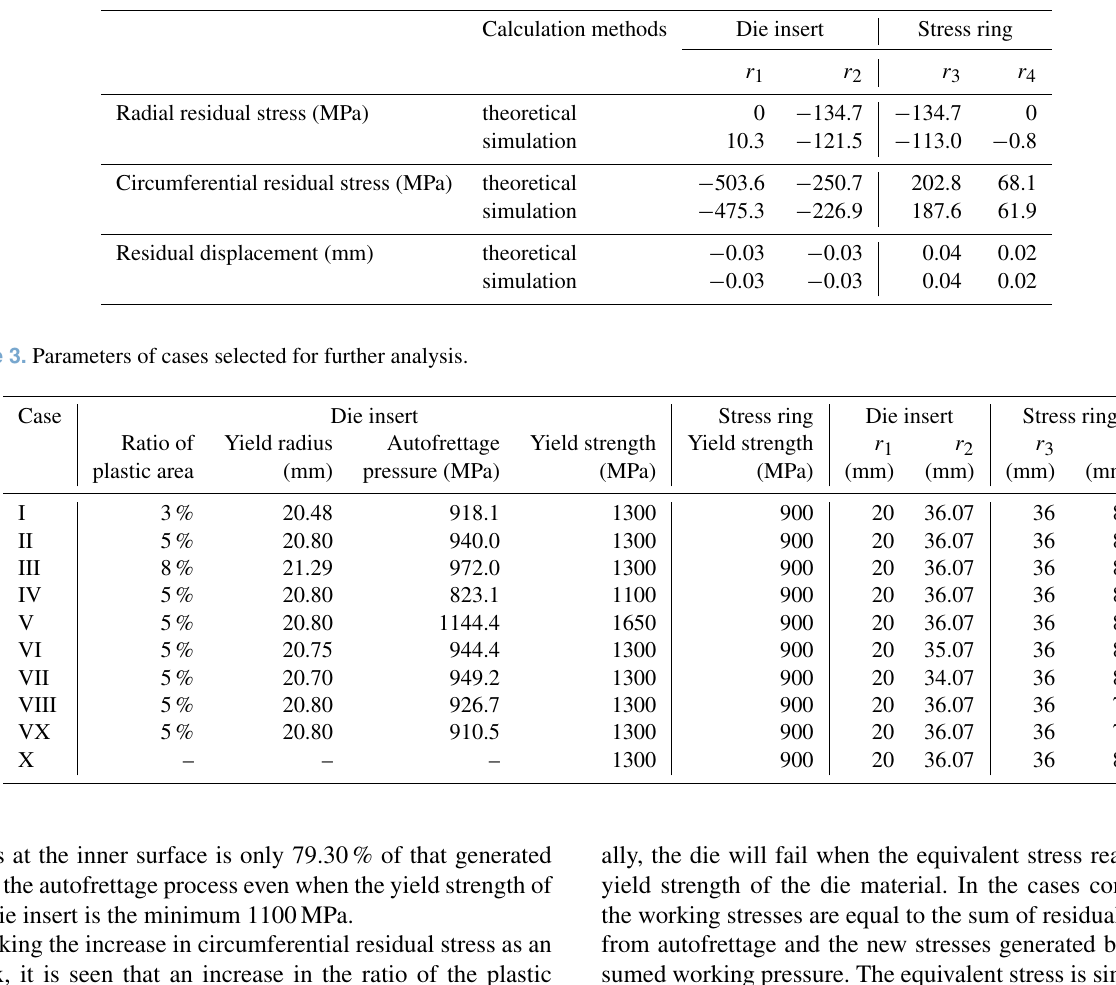
Table 2. Residual stresses and displacements at die boundaries.